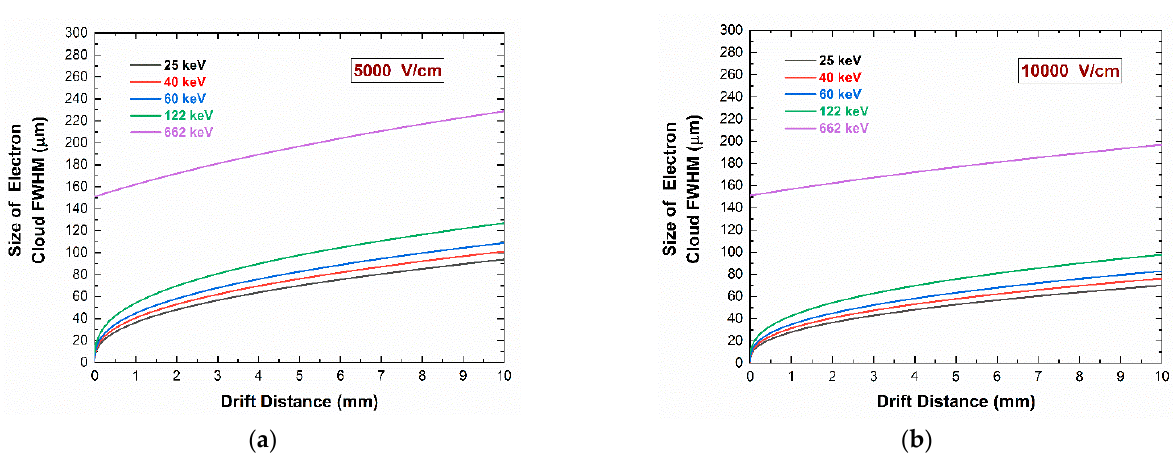
Figure 1. Evolution of electron cloud size (FWHM) vs. the drift distance in CZT detectors generated by photoelectrons in the energy range of 25–662 keV; Coulomb repulsion and charge diffusion are used in the simulation [26]. ( a ) Electric field of 5000 V/cm; ( b ) 10,000 V/cm.